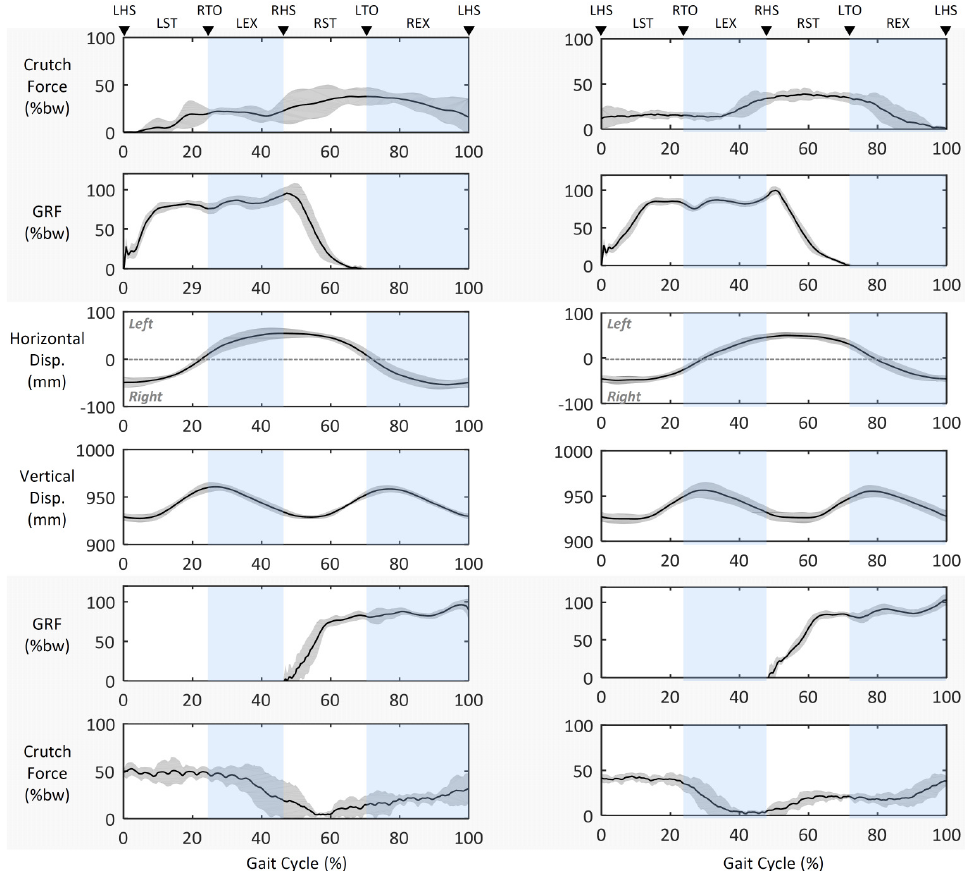
Figure 5. Center of mass trajectory, ground reaction force, and crutch force for each side during a gait cycle under the RGO condition ( left ) and the POWERED condition ( right ).